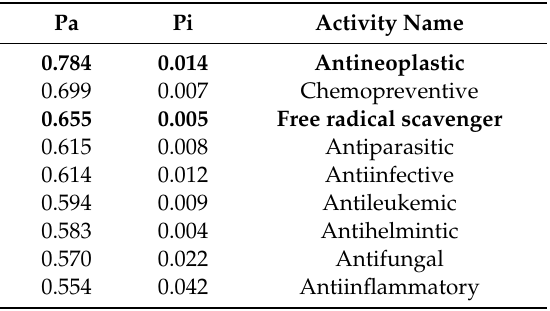
Table 2. Activity prediction of RA (only the top ten Pa values are